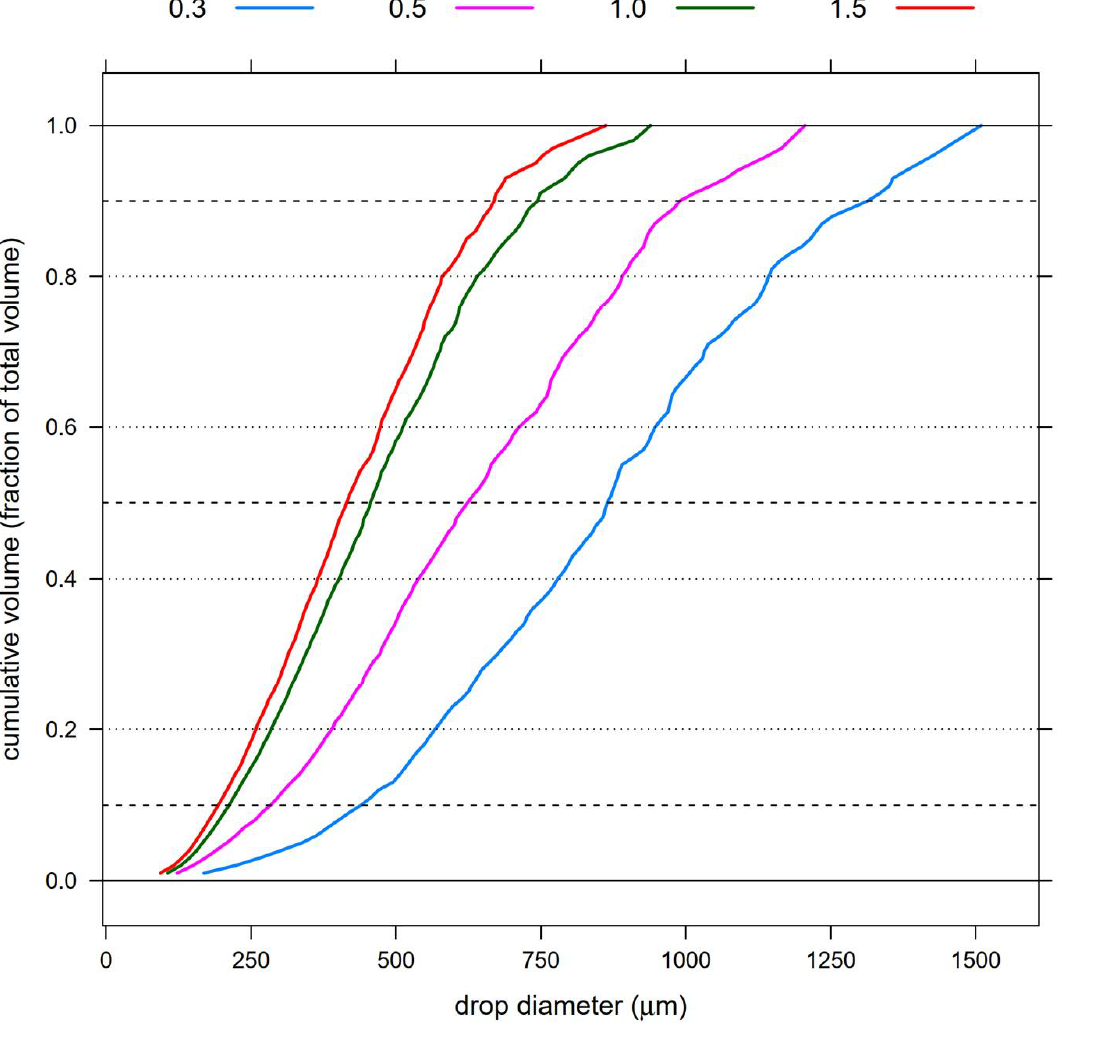
Figure 4. Cumulative volume curves as affected by spraying pressure.